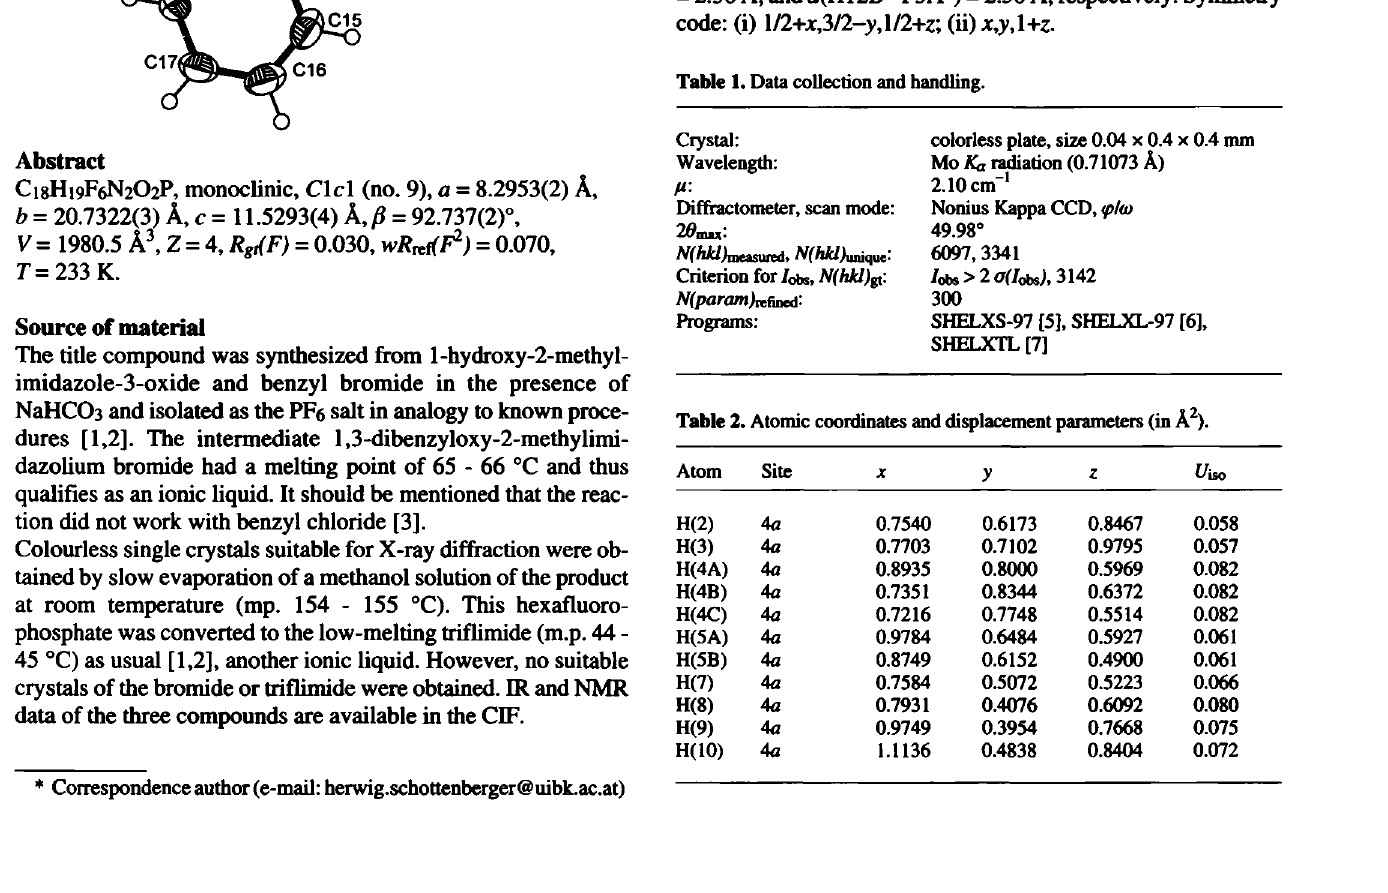
Table 1. Data collection and handling.